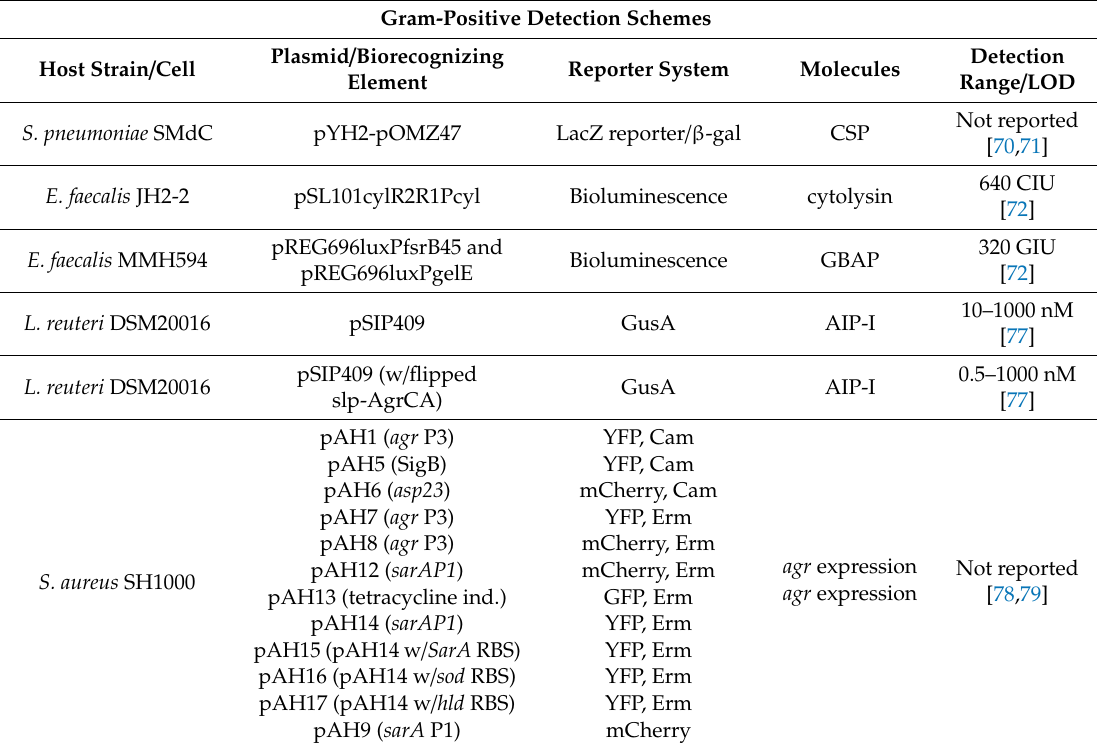
Table 2. Gram-positive detection